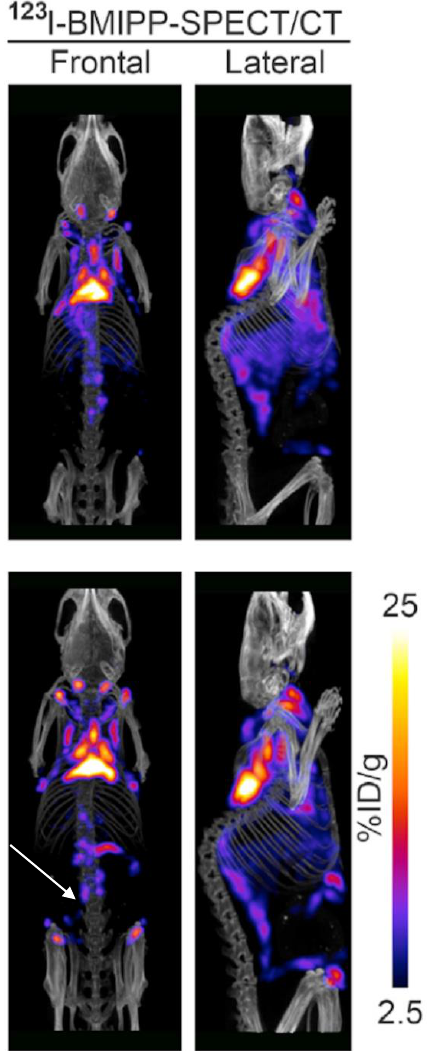
Figure 8. BMIPP-SPECT/CT with and without beta-adrenergic stimulation. BMIPP-SPECT/CT scanning for the patterns of fatty acid uptake in the metabolic active fat tissues of adult mice at room temperature after 7 days of vehicle treatment (top) or 7 days of treatment with the β 3 -adrenergic agonist CL-316243 (bottom row). Treatment increased uptake in classical interscapular BAT cervical depots, and inducible anteriorabdominalsubcutaneous(arrow)andinguinalmetabolicallyactivefattissue. Imagereproduced with permission from reference